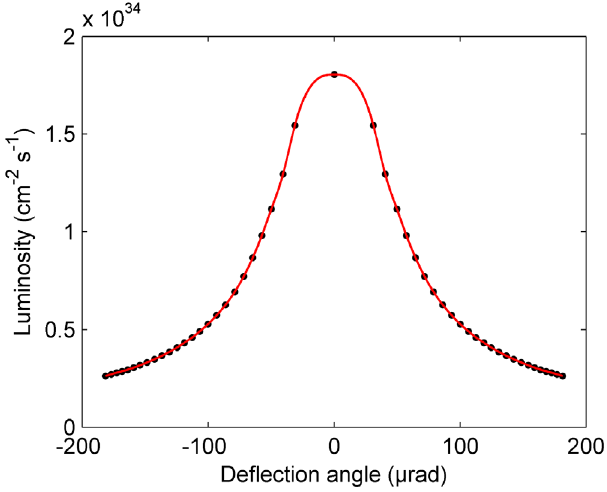
FIG. 6. Layout of the ATF showing the location of the FONT